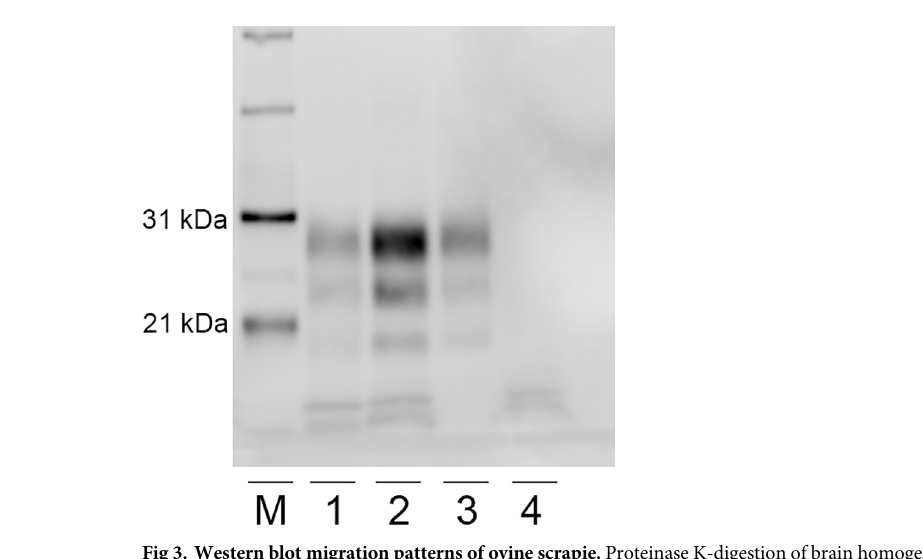
S1 Fig. Raw image for western blot from Fig 3. (PDF)